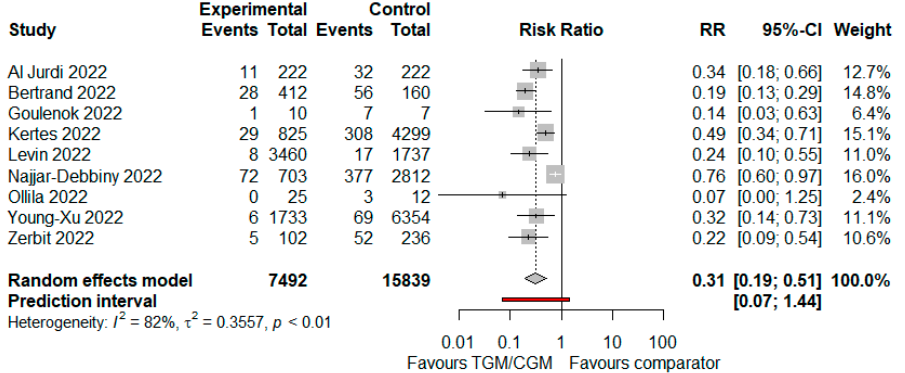
Figure 11. Rate of RT PCR SARS-CoV-2 positivity (TGM/CGM vs. comparator). CI, confidence interval; RR, risk ratio; TGM/CGM, tixagevimab/cilgavimab.